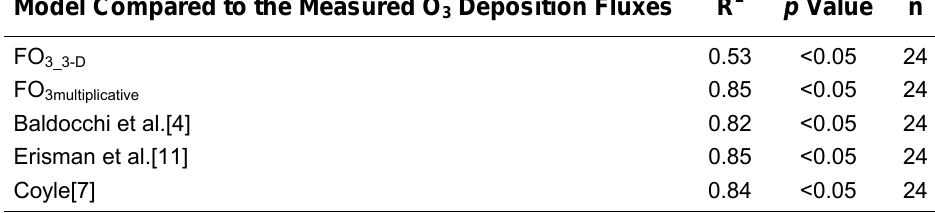
Regression Analysis for Measured Ozone Deposition Fluxes vs. Several Models of Ozone Deposition and Stomatal Ozone Fluxes, for 2000. Model Compared to the Measured O Deposition 3